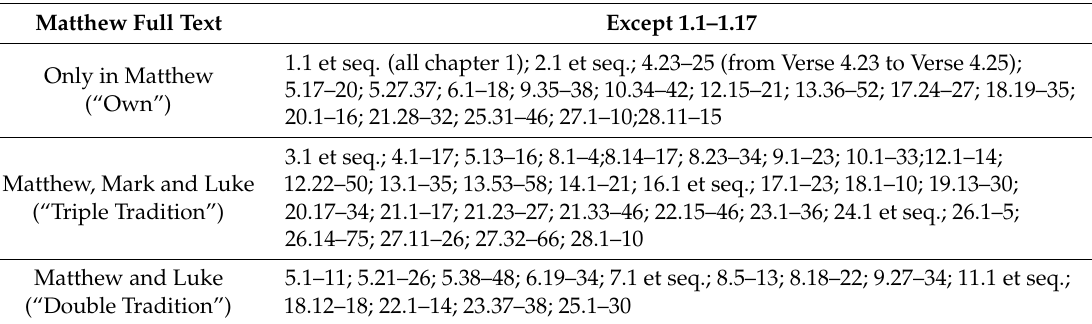
Table 3. List of the verses considered in Matthew, in the indicated texts. The list of names (Genealogy) in Verses 1.1–1.17 17 has not been considered in the statistical